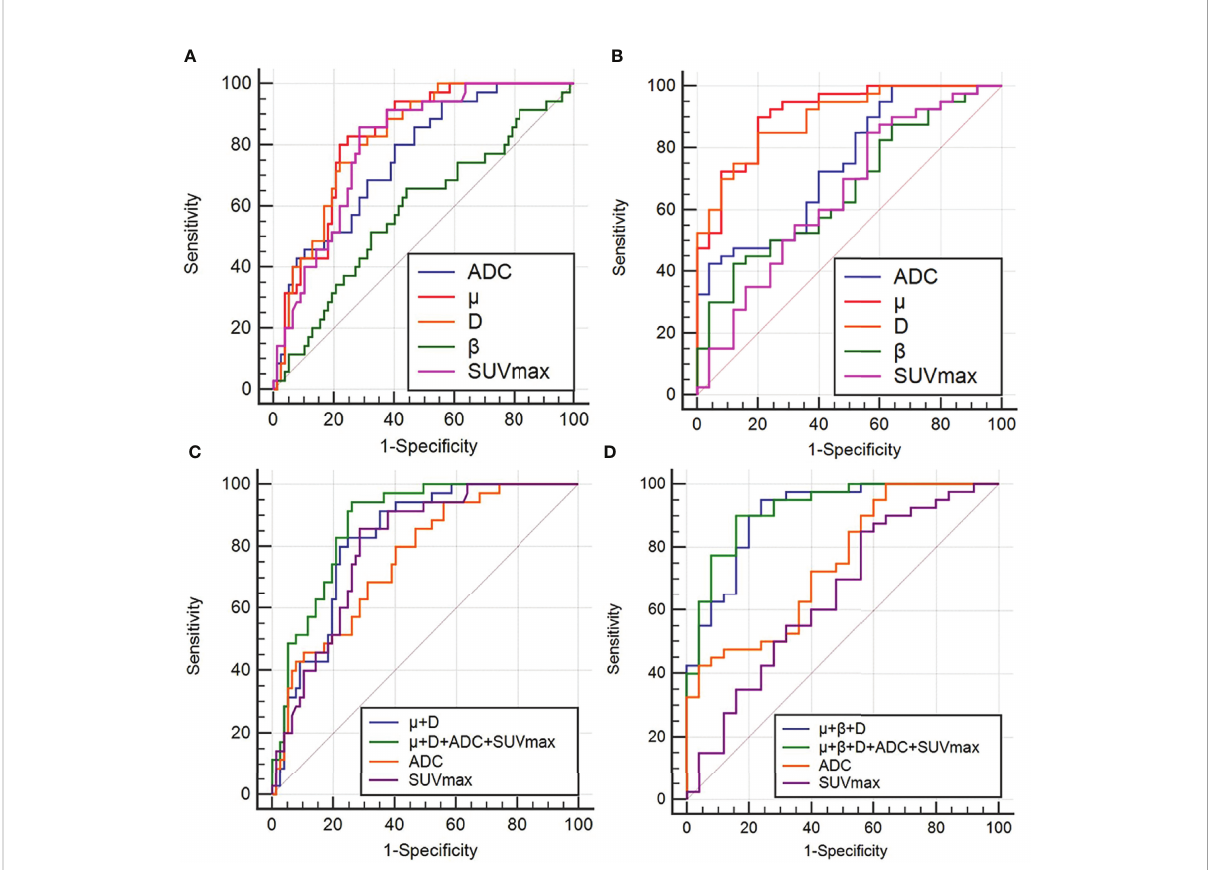
FIGURE 5 ROC curves of ADC, m , D, b , SUVmax and different combinations of m , D, b , ADC and SUVmax to distinguish between benign and malignant groups (A, C) , and between AC and SCC groups (B, D) . ROC analysis for differentiation of malignant and benign groups (A, C) ; ROC analysis for differentiation of adenocarcinoma (AC) and squamous cell carcinoma (SCC) groups (B, D)